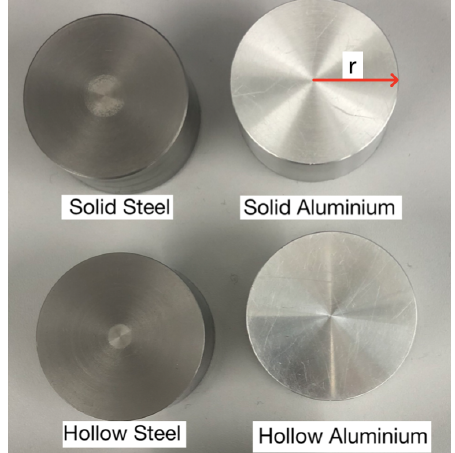
Figure 2. 6061 T6 aluminium and 440c steel